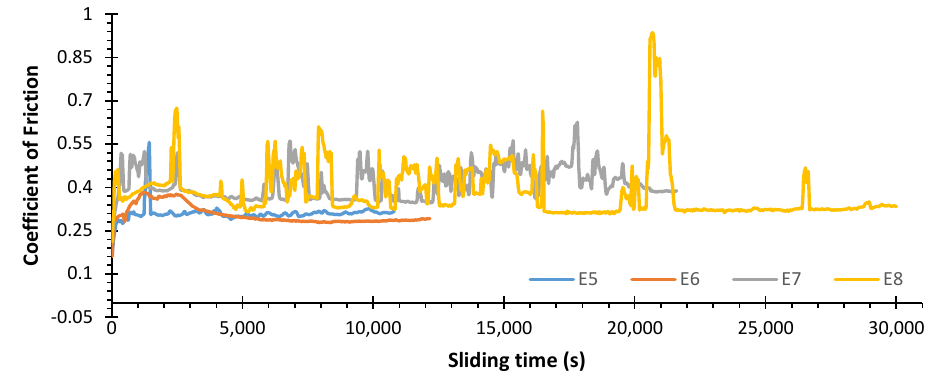
Figure A3. Coefficient of Friction (COF) curves of the tests performed for the system WC-Co/Al 2 O 3 .